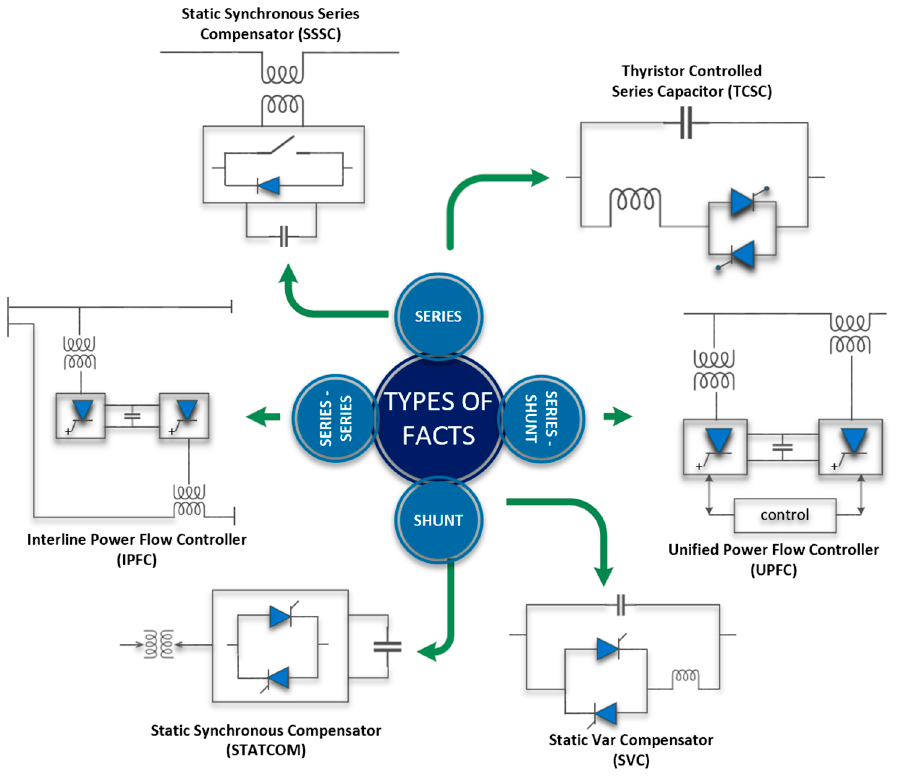
Figure 5. Different types of FACTS devices.